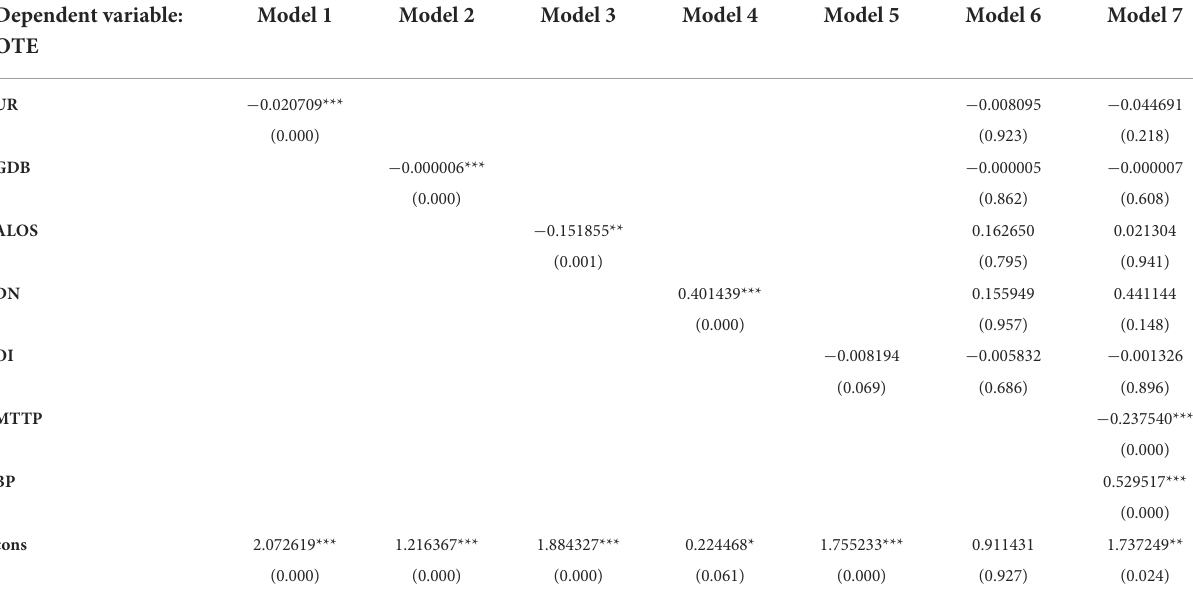
TABLE 11 Results of bootstrapping truncated regression for